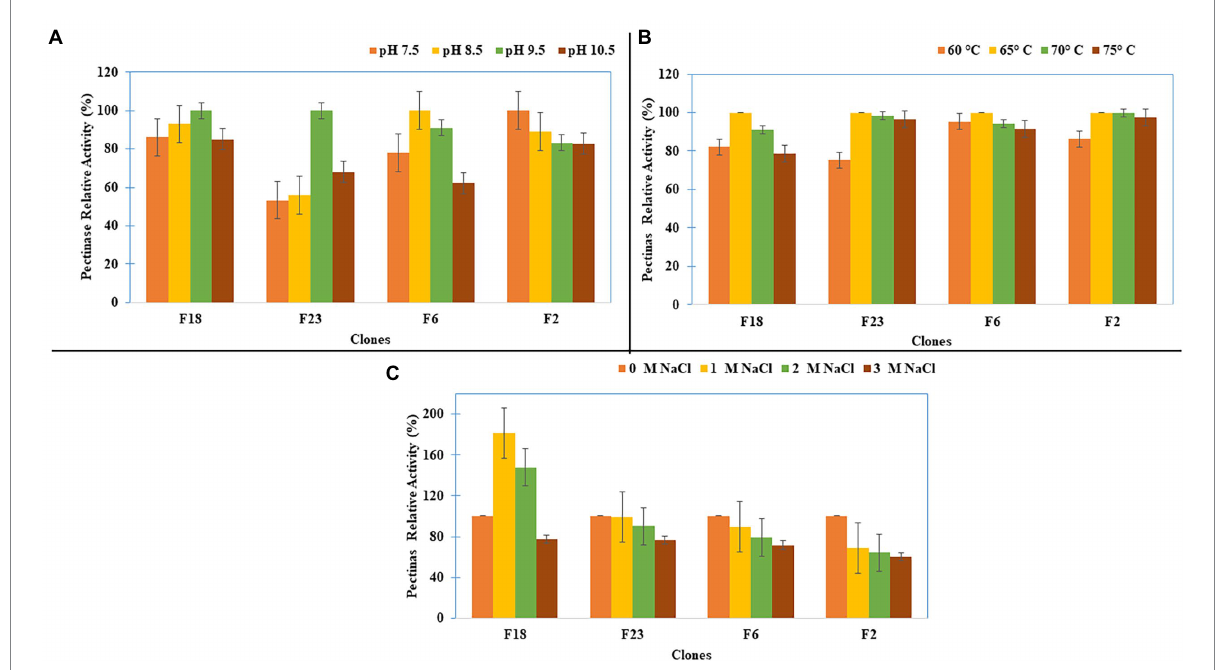
FIGURE 5 Pectinase Activity characterization of the clones for (A) pH, (B) Temperature, and (C) Salt